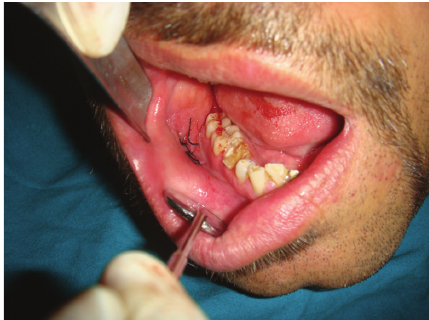
Figure 3: Postoperative picture.